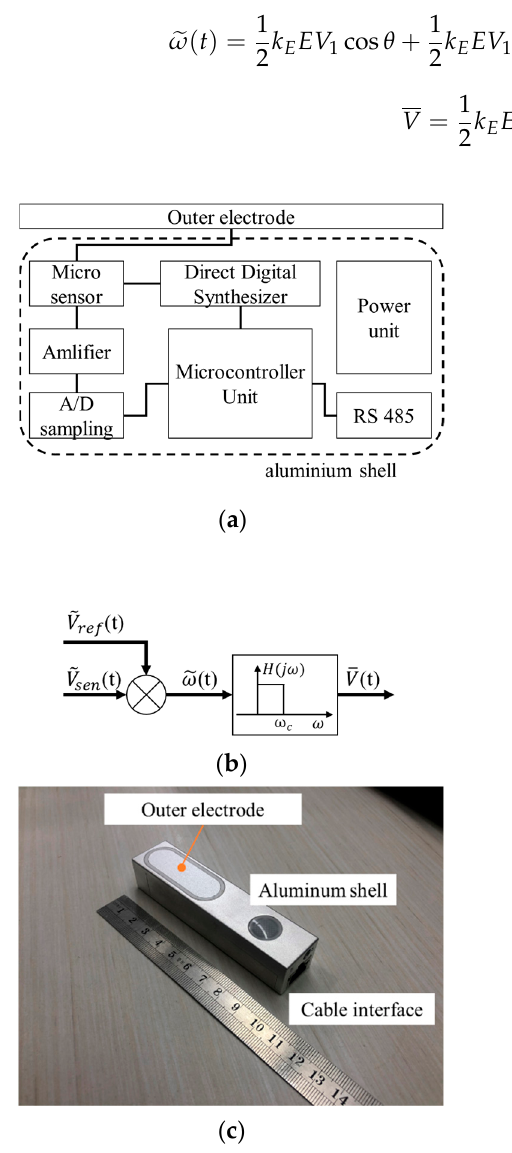
Figure 3. Signal processing circuit of the microsensor. ( a ) Circuit diagram. ( b ) Phase-sensitive demodulation algorithm. ( c ) Photo of the electrostatic meter prototype.